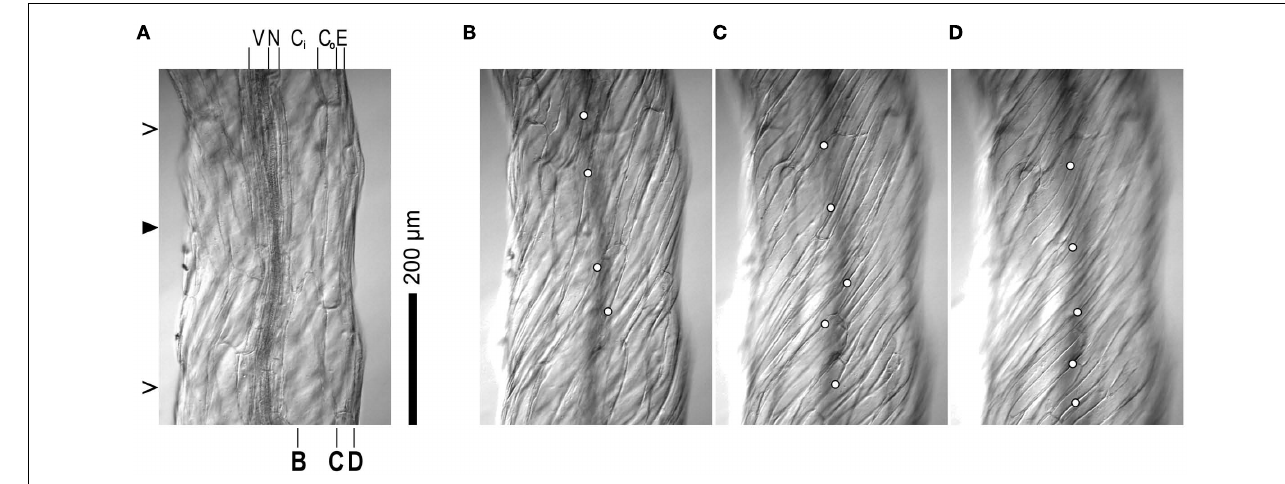
view (closed) or lie parallel with each other in the optical plane, respectively, (open) causing the xylem to appear as two separate strands. Circles in (B–D) identify longitudinal cell walls used for pitch measurements.The micrographs shown are elements of the image stack presented as File S1 in Supplementary Material. Plants were grown on half strength MS, 1% sucrose medium at 22˚C in the dark for 7days. Images were captured with a Micropublisher 5.0 RTV CCD camera (QImaging, Surrey, BC, Canada) on a Vanox microscope (Olympus Imaging America Inc., CenterValley, PA,